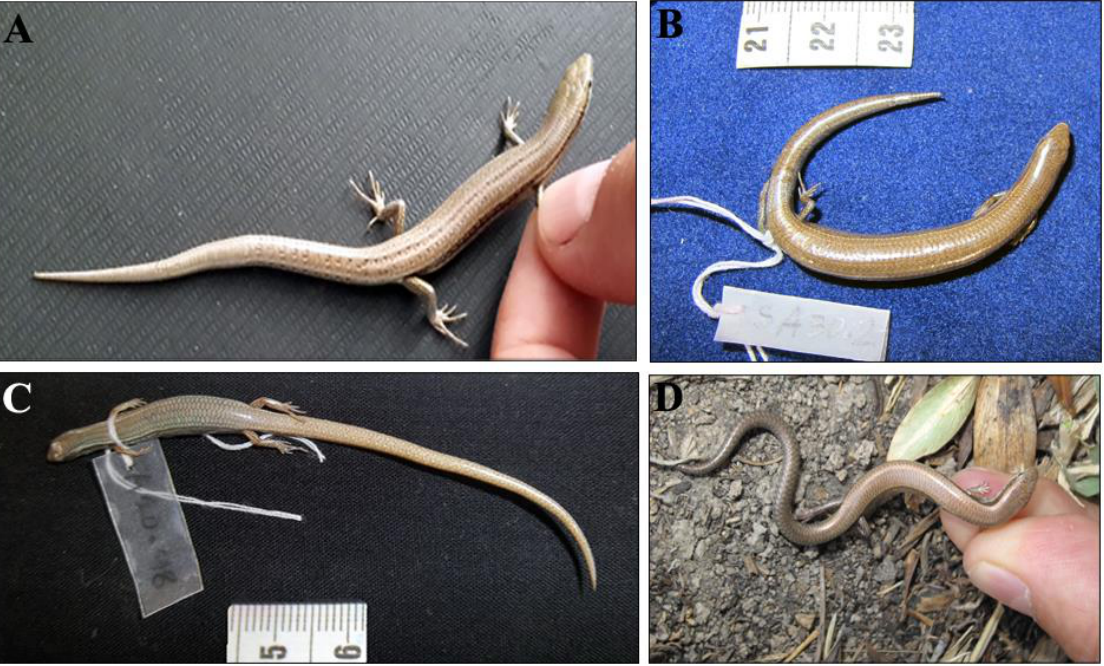
F IGURE 4. Adult specimen of ( A ) Ablepharus bivittatus (Ménétriés, 1832), ( B ) A. chernovi Darevsky, 1953, ( C ) A. grayanus (Stoliczka, 1872), and ( D ) A. pannonicus (Lichtenstein,